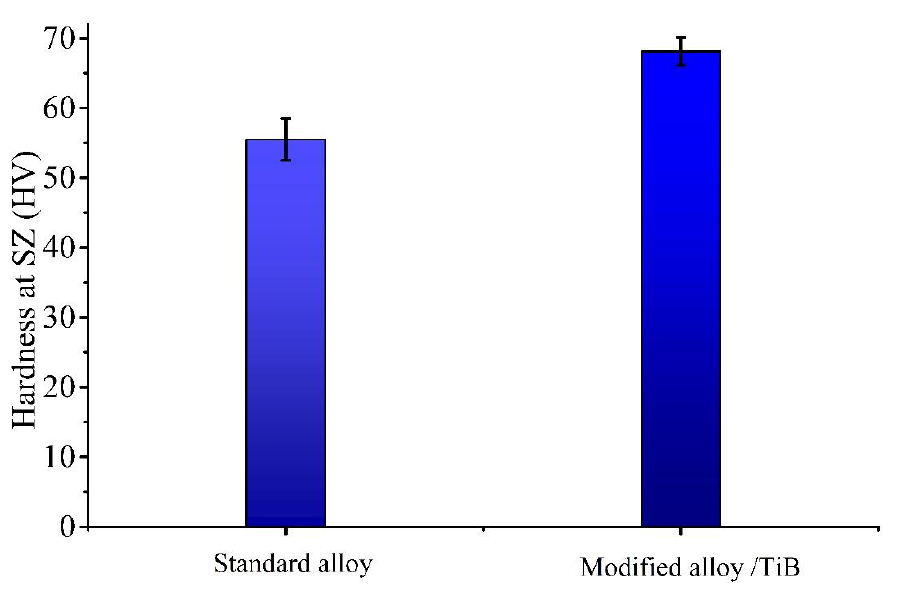
Figure 9. The hardness of the investigated alloys.